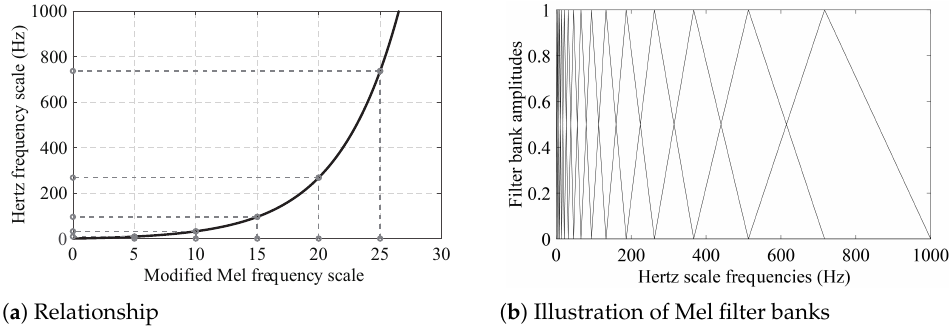
Figure 2. Relationship between modified Mel- and Hertz-scale frequencies and illustration of Mel filter